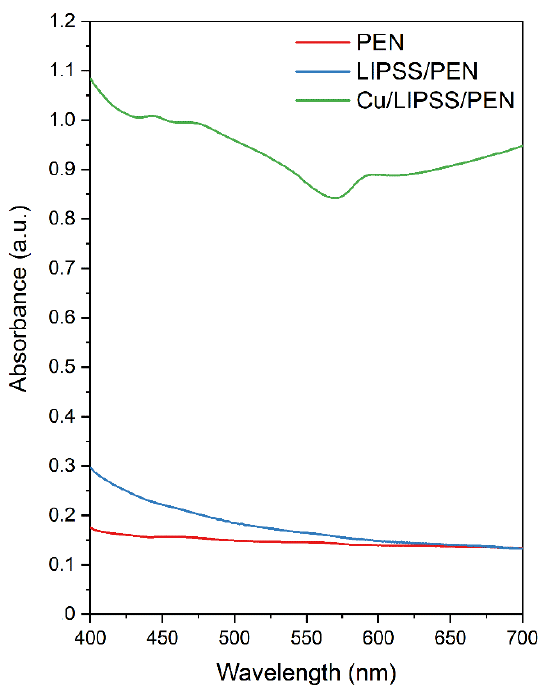
Figure 5. Absorption spectra of pristine, LIPSS/PEN, and Cu/LIPSS/PEN.